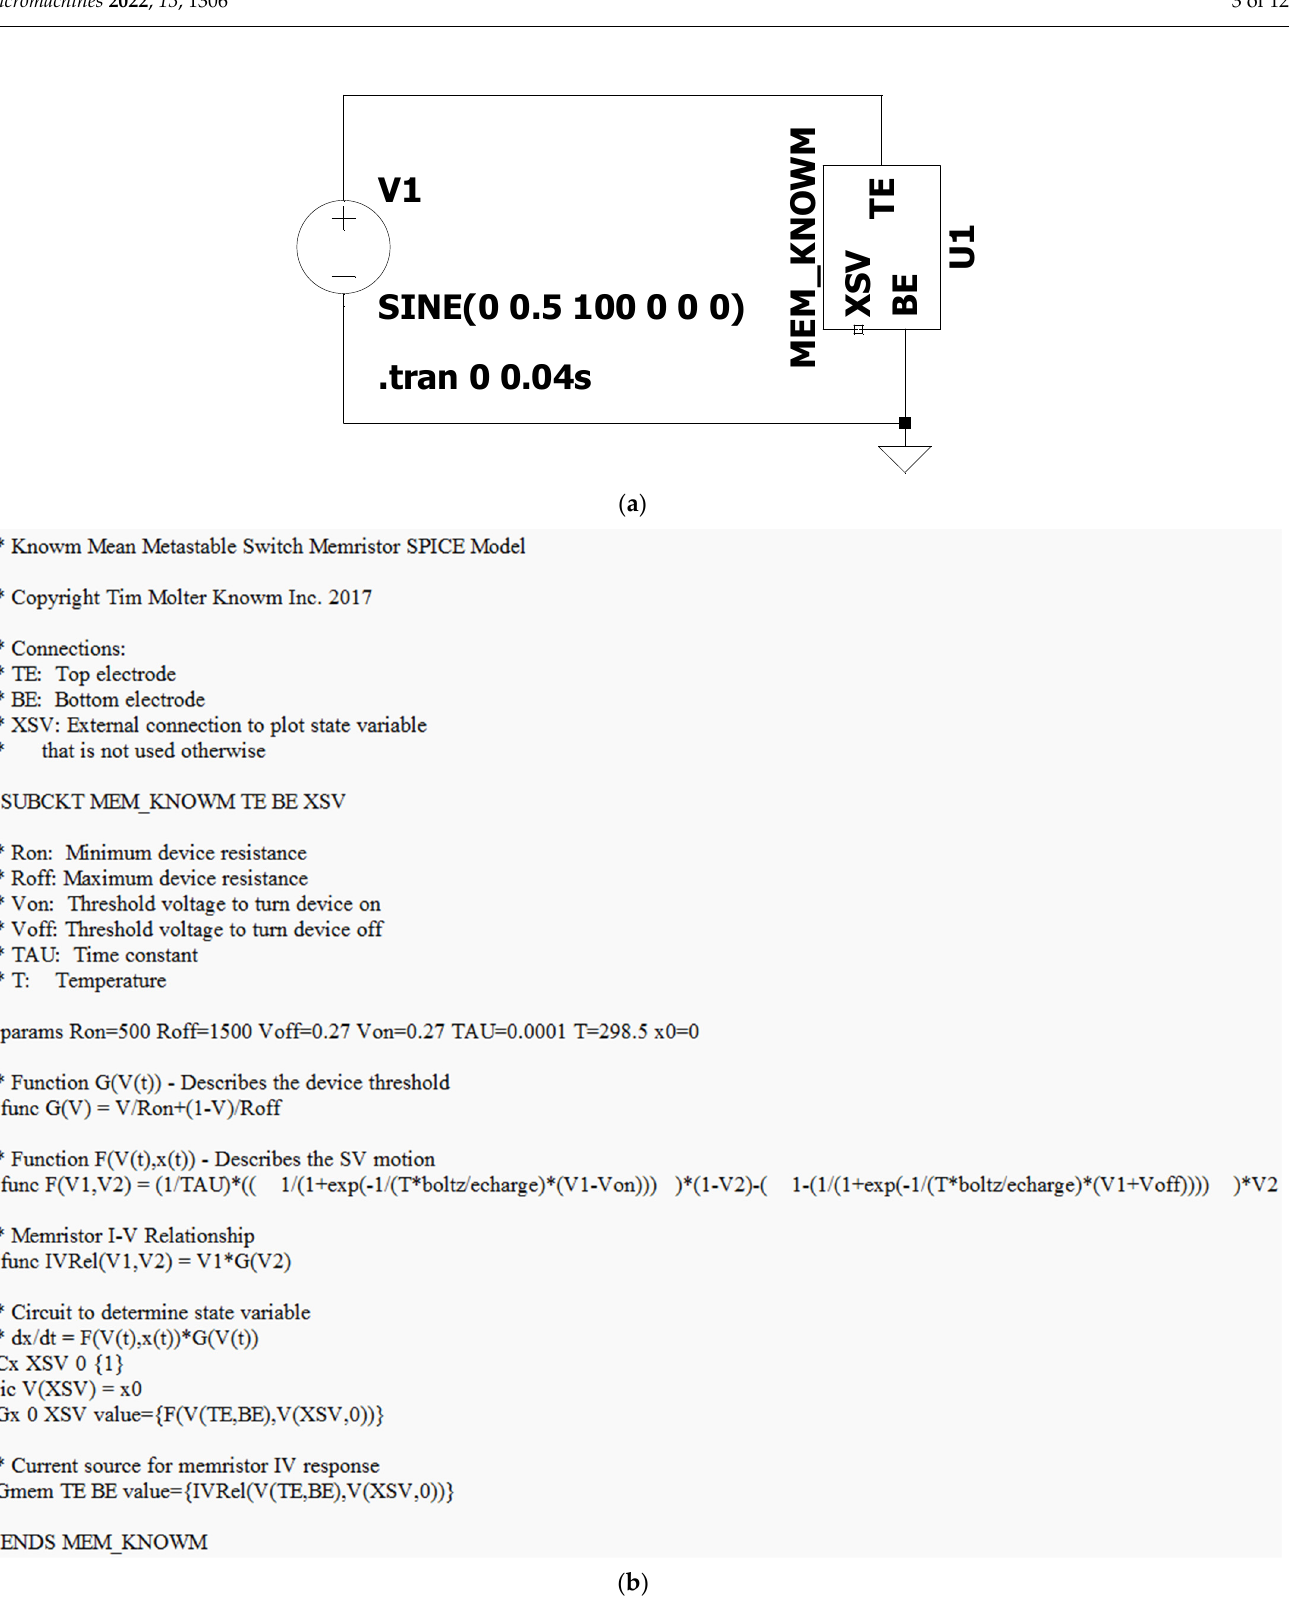
3 of 14 Table 1. List of parameters of the memristor model. Parameter